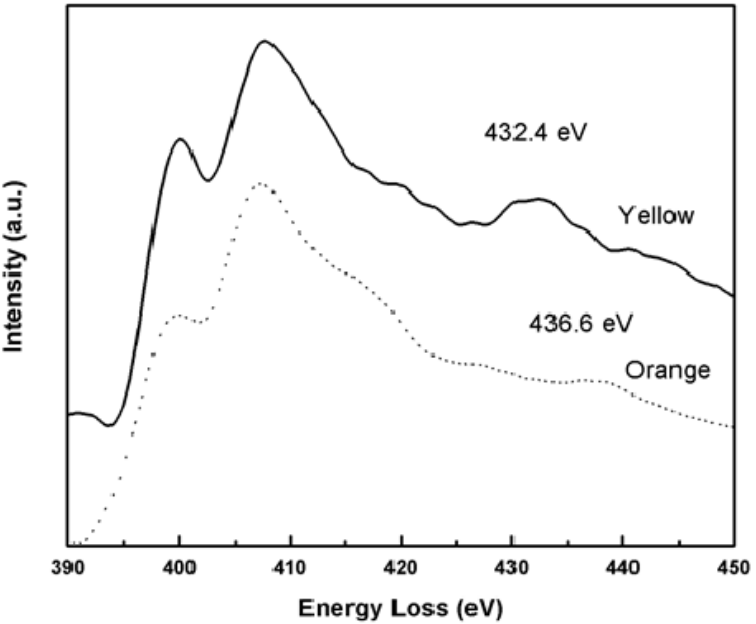
Figure 6. Nitrogen K ionization edge, showing π *, σ * and multiple scattering resonance signal in yellow (continuous) and orange (dotted)